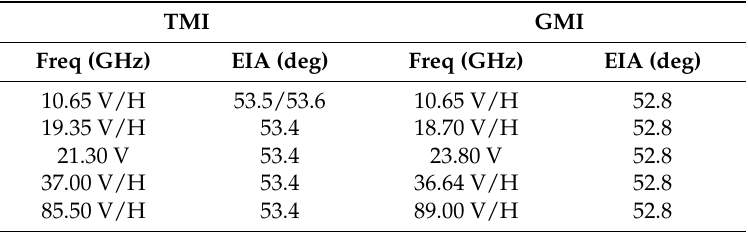
Table 1. Center frequency and earth incidence angle (EIA) of TMI and GMI